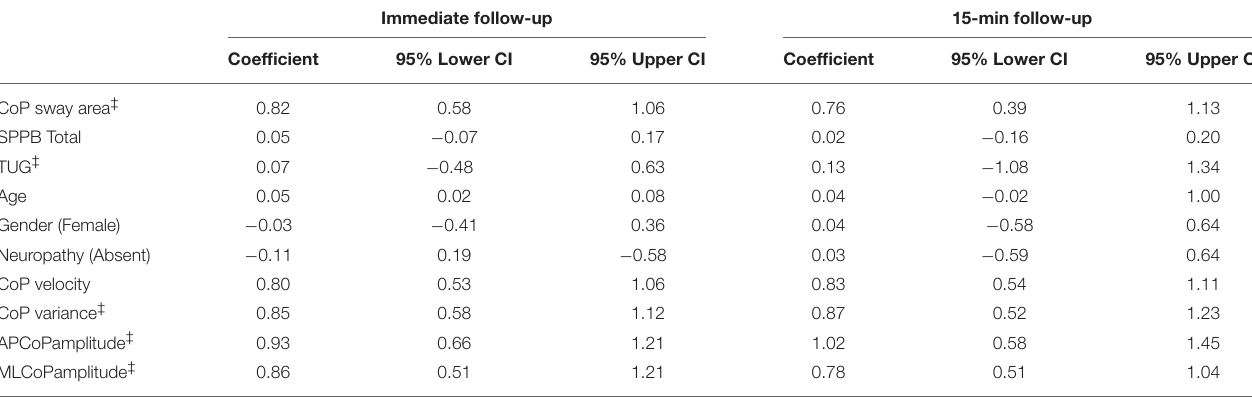
TABLE 2 | ANCOVA analyses at immediate and at 15-min follow-up, controlled for Baseline CoP sway area, SPPB total score, TUG, age, gender, and the presence (or not) of